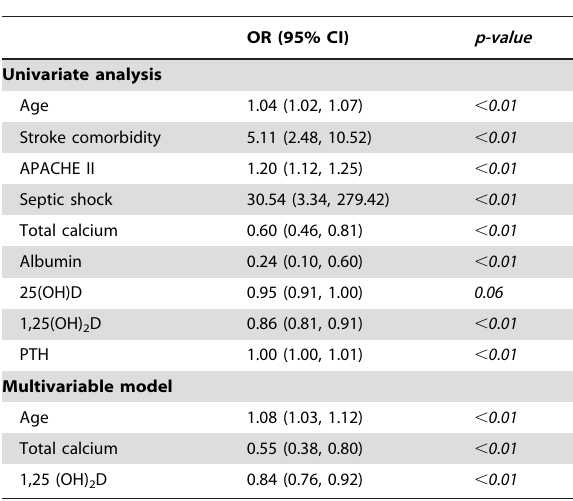
Table 3. Generalized estimating equations modeling using univariately statistically significant variables associated with 30-day mortality to derive a multivariable mortality prediction model.